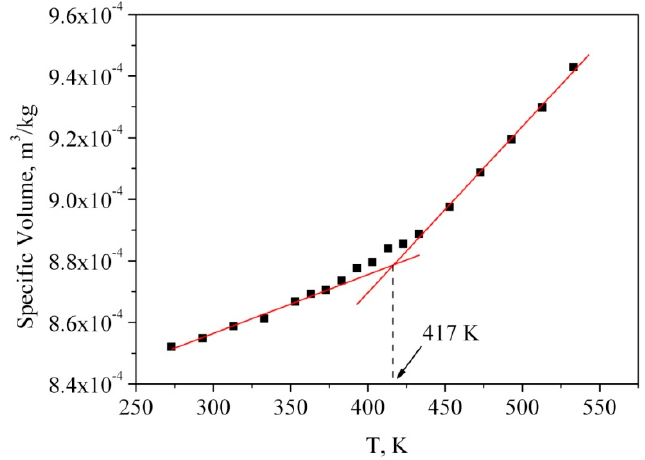
Figure 2. Dependence of specific volume of molecular dynamics (MD) simulation for PMMA.